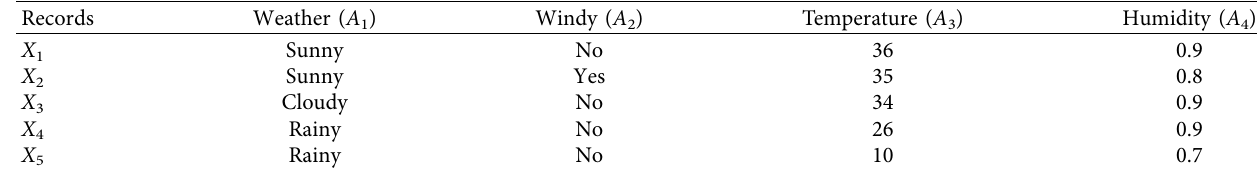
Table 1: A sample mixed-attribute